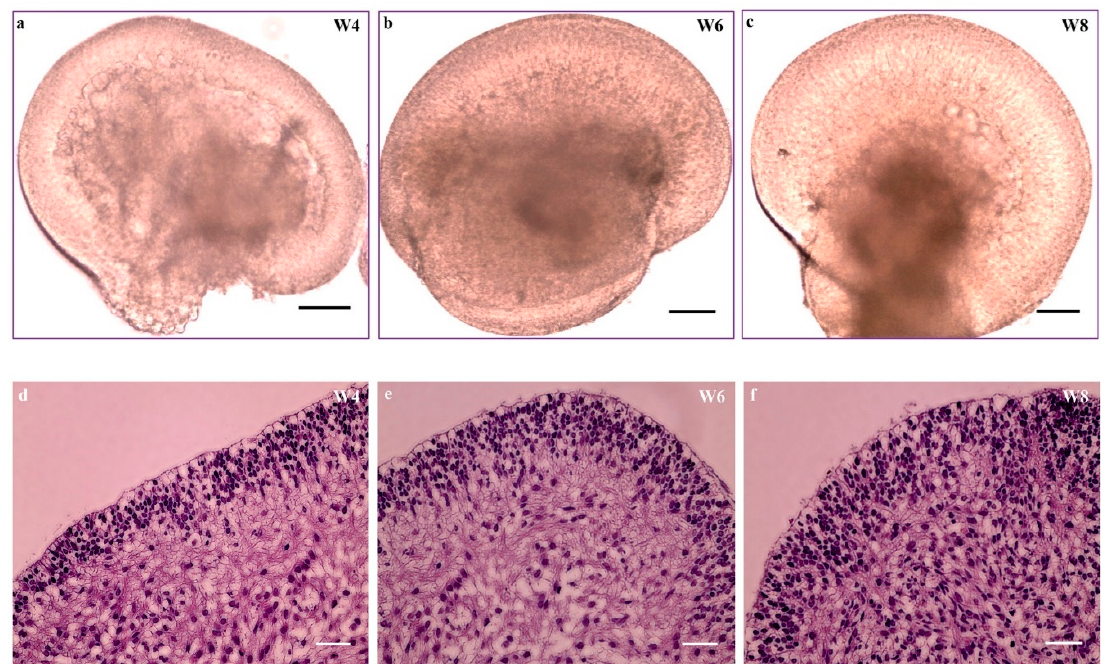
Figure 5. Hematoxylin and eosin staining of retinal organoids derived from hiPSCs. ( a – c ) Retinal organoids and ( d – f ) H&E staining of cryosectioned organoids at week 4 ( d ); week 6 ( e ); and week 8 ( f ). Scale bar, 200 μ m ( a – f